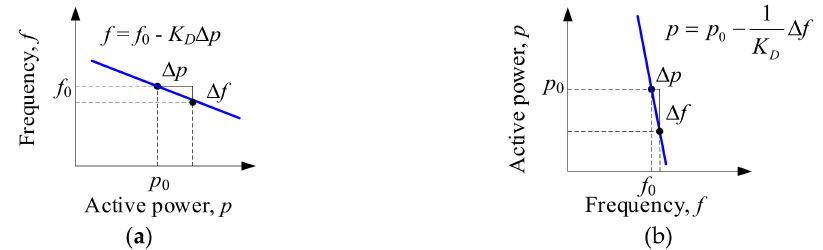
Figure 2. Comparison of the operational characteristics according to the droop action: ( a ) synchronous generator governors and ( b ) virtual inertia (VI)